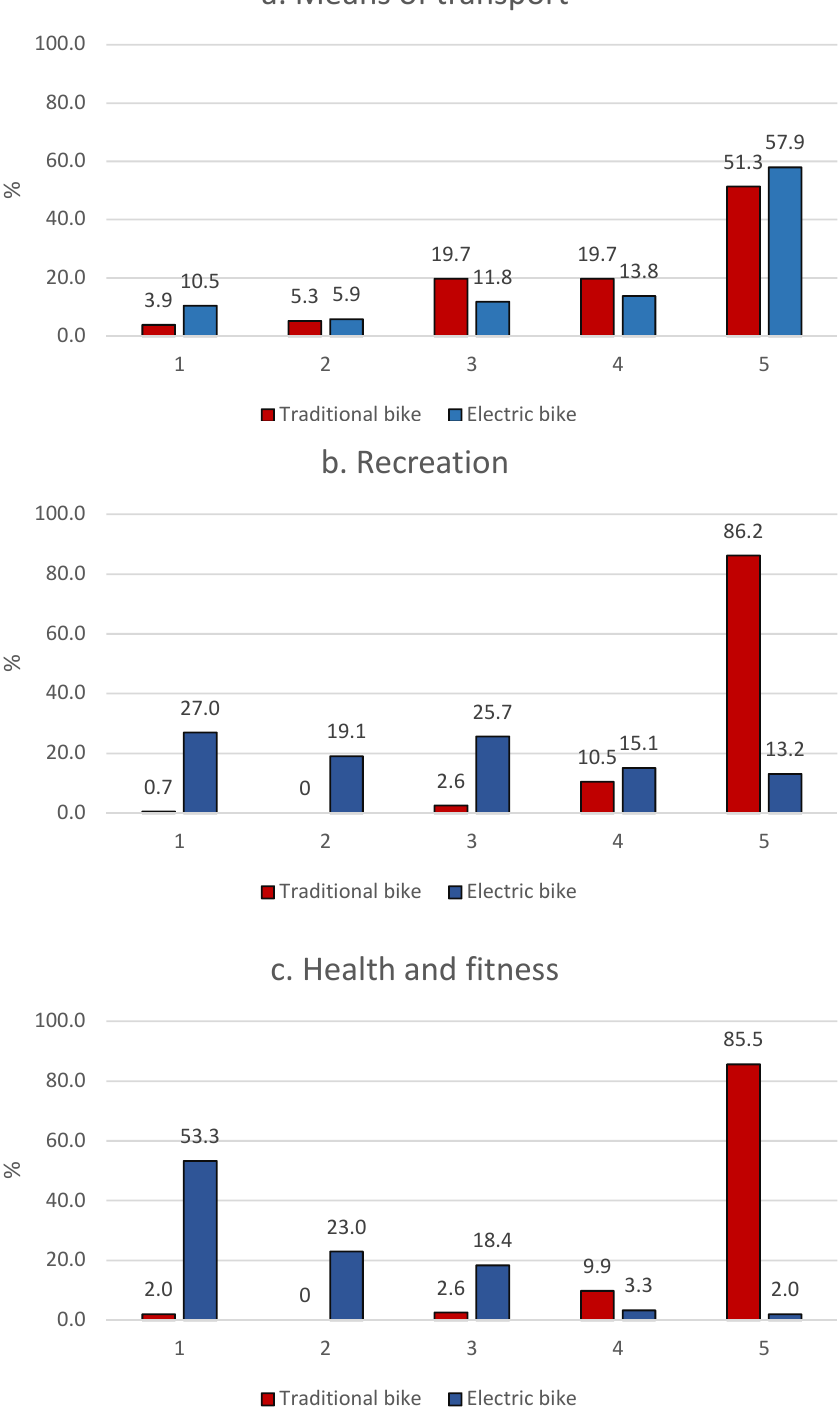
Figure 1. Structure of answers to the question: “What do you think the traditional bicycle and the electric bicycle are used for? (1—least, 5—most)”. Source: Own elaboration on the basis of the questionnaire survey .